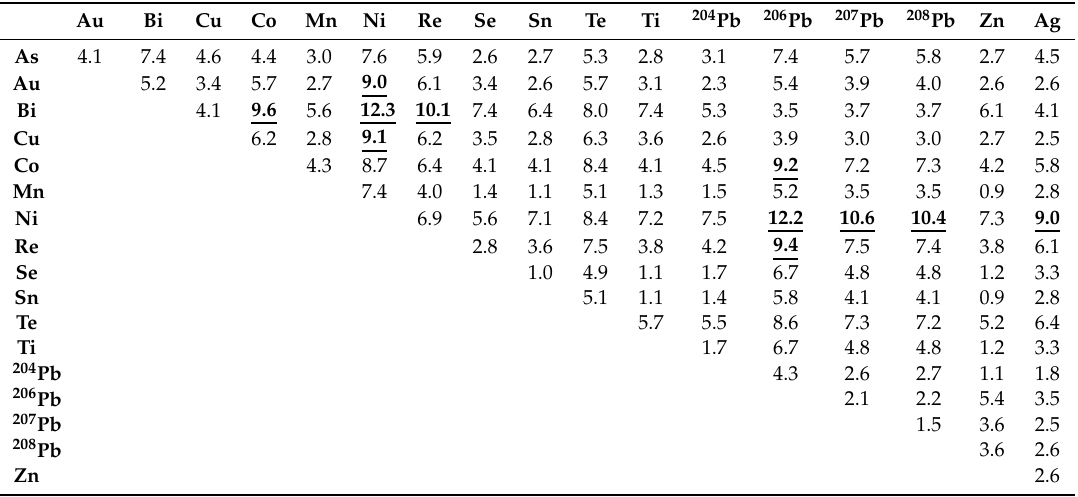
Table 2. Variation matrix for the N = 4926 dataset with entries as the variances of log-ratios for each element pair. The underscored values indicate the weakest column-wise